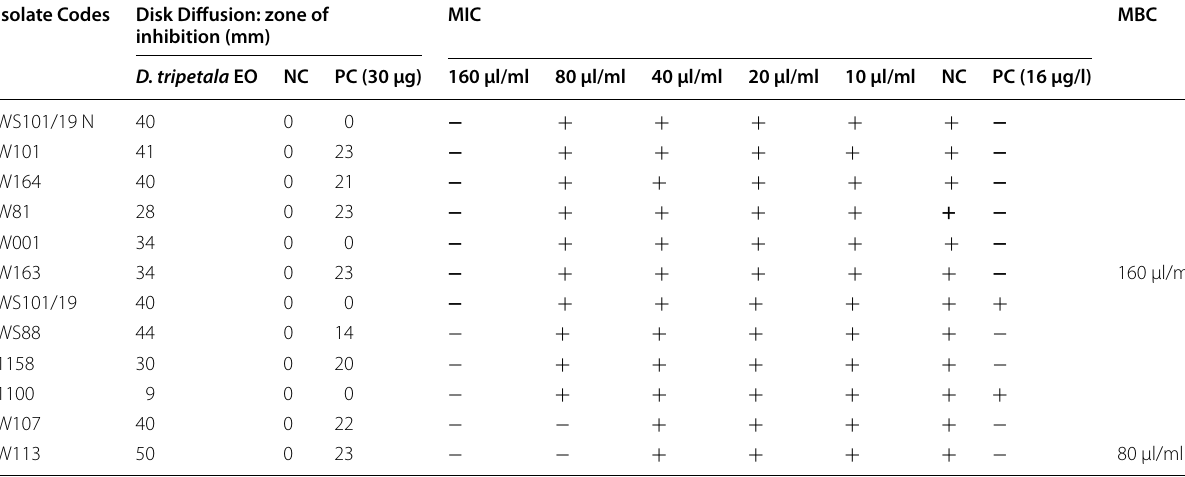
(visible growth), NC Negative control (5% Polyethylene glycol), PC Positive control (vancomycin, +